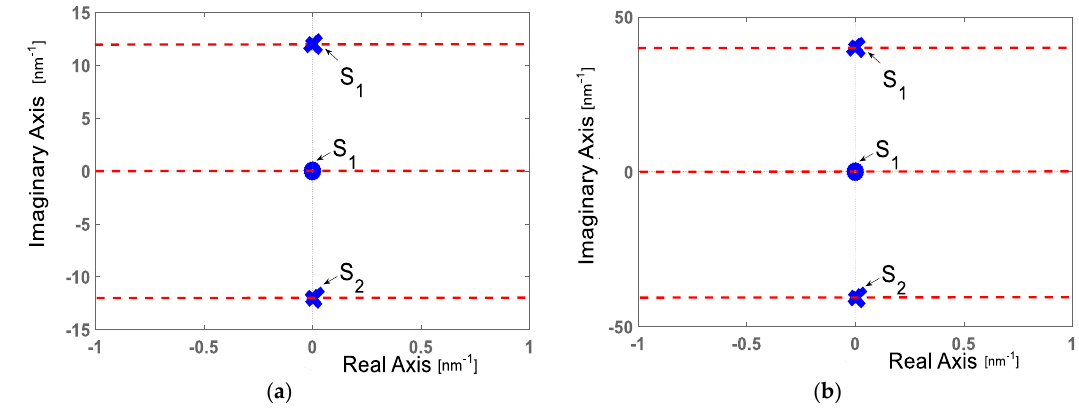
Figure 8. Pole-zero map representation: ( a ) complex function 𝐹 1 (𝑠) ; ( b ) complex function 𝐹 2 (𝑠) .